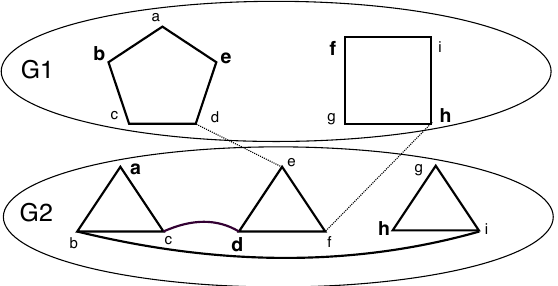
Figure 2. MIS: Graph G consists of two layers, G 1 and G 2 . The same graph is employed for the illustration of other problems. The vertices of a maximum independent set are { b , e , f , h } from G 1 and { a , d , h } from G 2 . The cardinality of any MIS of G is 7. The vertices of MIS are shown in larger bold